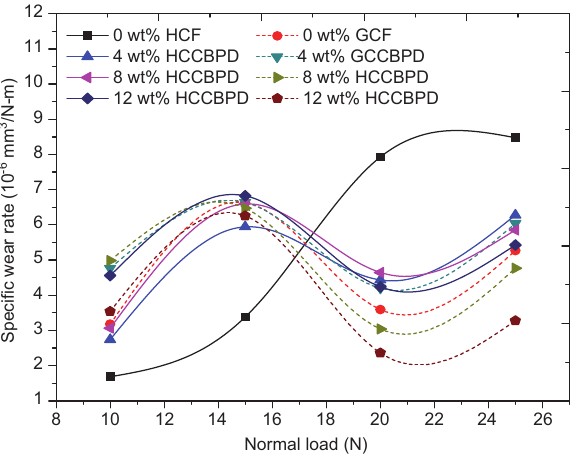
Figure 6 Variation of specific wear rate on normal load of compos- ites (constant sliding distance = 1 km, sliding velocity = 2.5 m/s and abrasive medium = 18 μ m).